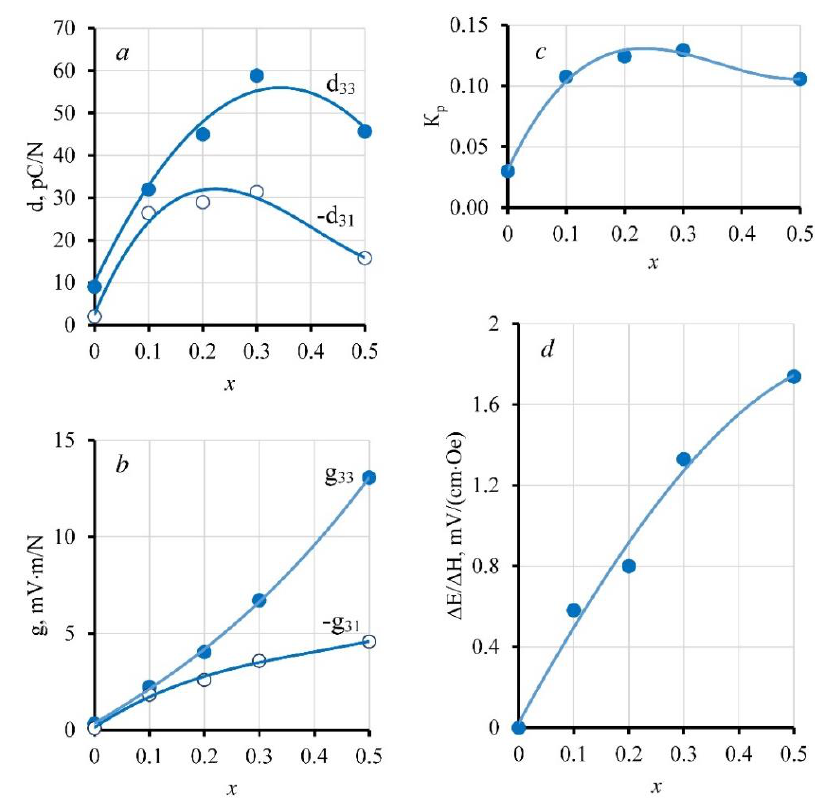
Figure 11. The concentration dependence of the piezoelectric coefficients d 33 and -d 31 ( а ), the piezoelectric voltage coefficients g 33 and -g 31 ( b ), the electromechanical coupling coefficient K p ( c ), and the ME coefficient ΔE/ΔH ( d ) of composite ceramics 50 wt.% PZTNB-1 + 50 wt.% Pb 1− x La x Fe 12− x Zn x O 19